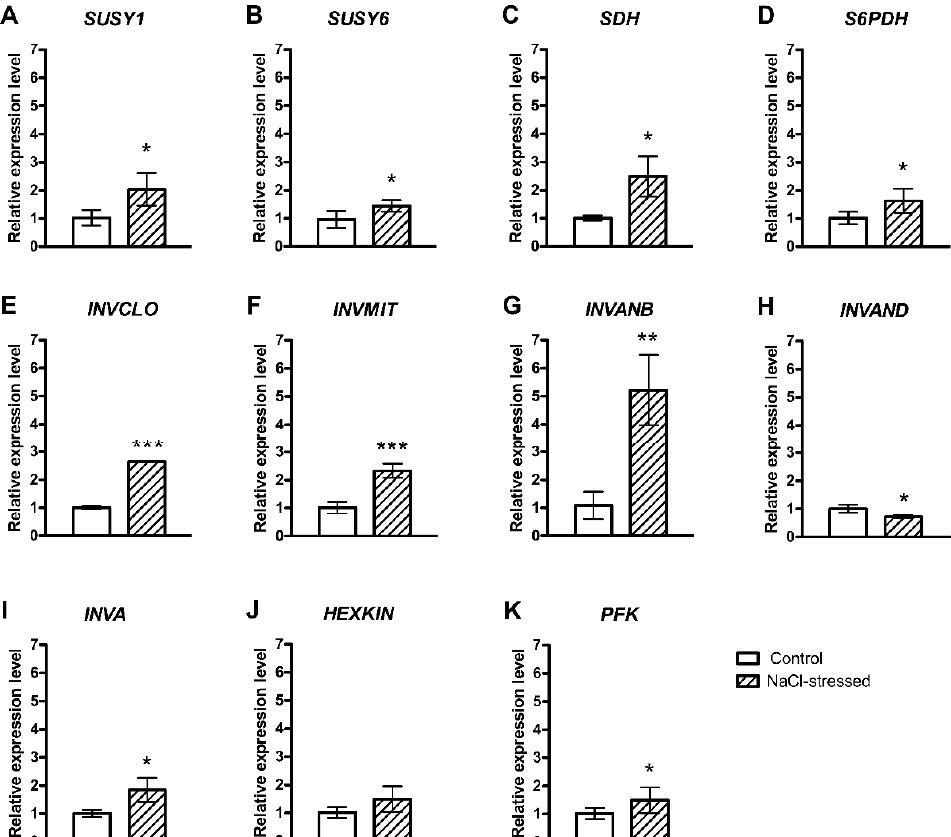
Figure 2. Relative expression of genes encoding carbohydrate metabolism in the pulp of F. carica (cv. Dottato) fruits harvested from 100 mM NaCl-stressed plants after 48 days. The values were determined with RT-qPCR. ( A ) Sucrose Synthases 1 ( SUSY1 ); ( B ) Sucrose Synthases 6 ( SUSY6 ); ( C ) Sorbitol Dehydrogenase ( SDH ); ( D ) NADP-dependent D-sorbitol 6-phosphate Dehydrogenase ( S6PDH ); ( E ) Alkaline-neutral Invertase-Like Chloroplastic ( INVCLO ); ( F ) Alkaline-neutral Invertase-Like Mitochondrial ( INVMIT ); ( G ) Alkaline-neutral Invertase B ( INVANB ); ( H ) Probable Alkaline-neutral Invertase D ( INVAND ); ( I ) Acid β -fructofuranosidase ( INVA ); ( J ) Hexokinase-1 ( HEXKIN ); ( K ) ATP-dependent-6-phosphofructokinase 3 ( PFK ). Fold change values are means ± SD of three biological replicates. Asterisks indicate statistically significant differences (* p ≤ 0.05, ** p ≤ 0.01, *** p ≤ 0.001).